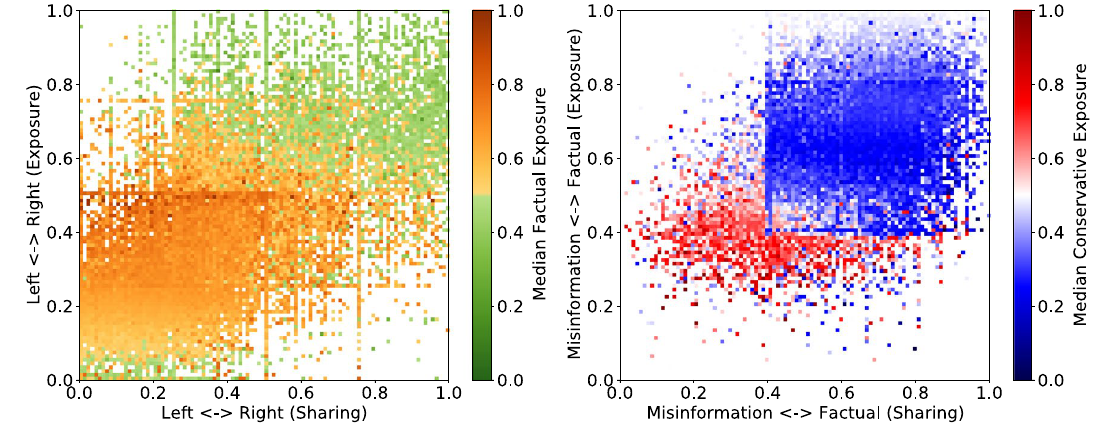
Figure 3. Exposure within echo chambers. ( a ) Color indicates the median factual exposure in each bin. In general, as users share more conservative content while being exposed to more conservative content, they also see more misinformation. Liberal users who are exposed to extreme liberal content also see more misinformation. ( b ) Color indicates the median political polarization score in each bin. Generally, as users generate more misinformation while being exposed to low factual content, they have a higher propensity to share conservative content ( p e ≈ 0 ) see more misinformation (green hue). As liberals become more exposed to conservative content ( p e → 1 ) they see more and more misinformation. The same is not true of conservatives: conservative users ( p l > 0.5 ) who are exposed to right-wing information ( p e > 0.5 ) tend to see more misinformation; however, as long as they are not too conservative, exposure to liberal information ( p e < 0.5 ) allows them to receive more factual information. Unlike liberals, exposure to politically moderate content ( p e ≈ 0.5 ) does not promote factual information among conservatives. Trends within misinformation echo chambers (Fig. 3b) tell a similar story. Users who share misinformation ( f l < 0.4 ) and are exposed to misinformation ( f e < 0.4 ) tend to see more conservative content (red), although those who are exposed to more factual content ( f e → 1 ) see more liberal information (blue dots). Among people sharing factual information ( f l > 0.6 ), those who are exposed to more factual information ( f e → 1 ) tend to see politically moderate content (white). The box outline is an artifact of domain polarity scores. MBFC classifies many information sources as “mixed” (0.4), leading to an overabundance of points near that value. Supplementary Fig. S2 (Refer Supplementary File) visualizes two-dimensional polarization within the echo chambers. Again, the neighborhood exposure vs leaning space is the same as the row above, but the color in each plot shows user polarization or leaning along the alternate dimensions. Supplementary Fig. S2a shows that as partisanship becomes more extreme ( p l → 0 or p l → 1 ), people are more likely to share misinforma- tion (green). Interestingly, this trend does not strongly depend on partisanship of their exposure ( p e ). Overall, liberals ( p l < 0.5 ) share more factual information, although those who are more moderate ( p l ≈ 0.5 ) tend to share more misinformation (yellow/green) when exposed to more conservative content ( p e → 1 ). As shown in Fig. 2b, misinformation-prone users ( f l < 0.4 ) tend to post more hardline conservative content (darker red) as they share more misinformation ( f l → 0 ) regardless of their exposure; however, those who are most exposed to misinformation ( f e < 0.2 ) tend to share more liberal views (blue dots). This is not true for factual users, who tend to share liberal content (blue) regardless of the factuality of their exposure ( f e ). Hardline partisans amplify misinformation. Do people amplify misinformation by selectively sharing fewer factual domains than what they are exposed to? The off-diagonal elements in the echo chamber plots in Fig. 1 suggest that a sizable fraction of social media users share information that is more polarized and less factual than what they are exposed to, and an equally large number share information that is more factual than what they are exposed to. In other words, some people filter out misinformation from the information ecosystem, while others amplify it. To better understand how the inter- actions between polarization and misinformation affect how people react to exposure, we define two quantities: